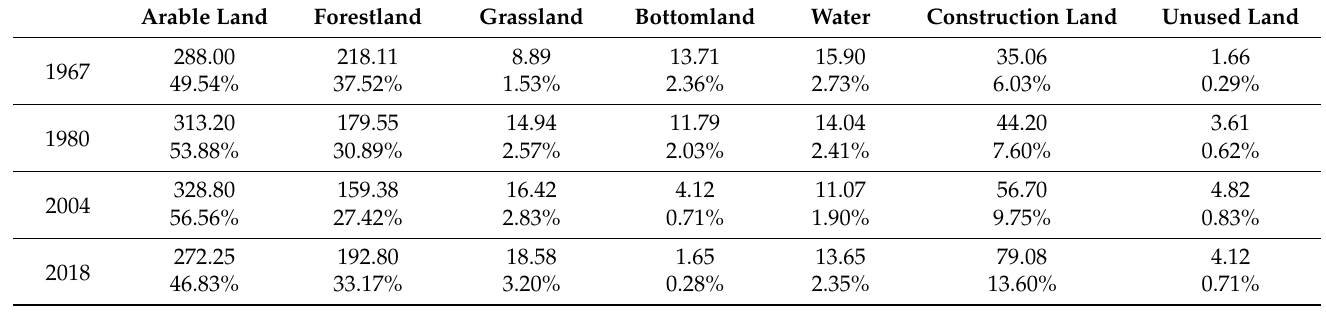
Table 6. Land use type area (km 2 ) and proportion from 1967 to 2018.